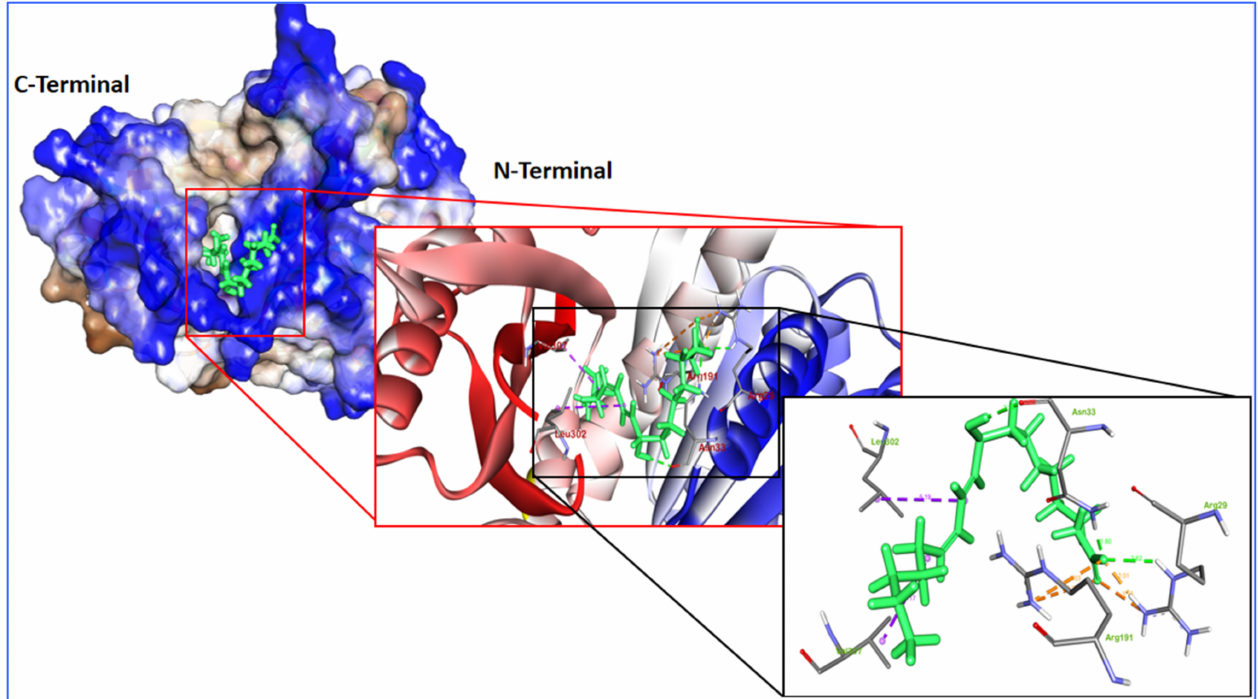
Figure 5. Surface is added to Fts-Z protein (PDB ID-2VXY) on the basis of hydrophobicity, and ADMA compound (in green) is shown to be docked in the binding cavity and another zoom in figure is shown for interacting residues of the protein with ligand. Further Zoom in view of the ADMA compound and interacting residues from binding cavity. The visualization was done through Biovia Discovery Studio